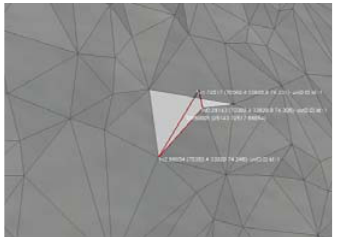
Figure 16. Problem case – triangles without texture on the 3D model of fortress Kristiansten